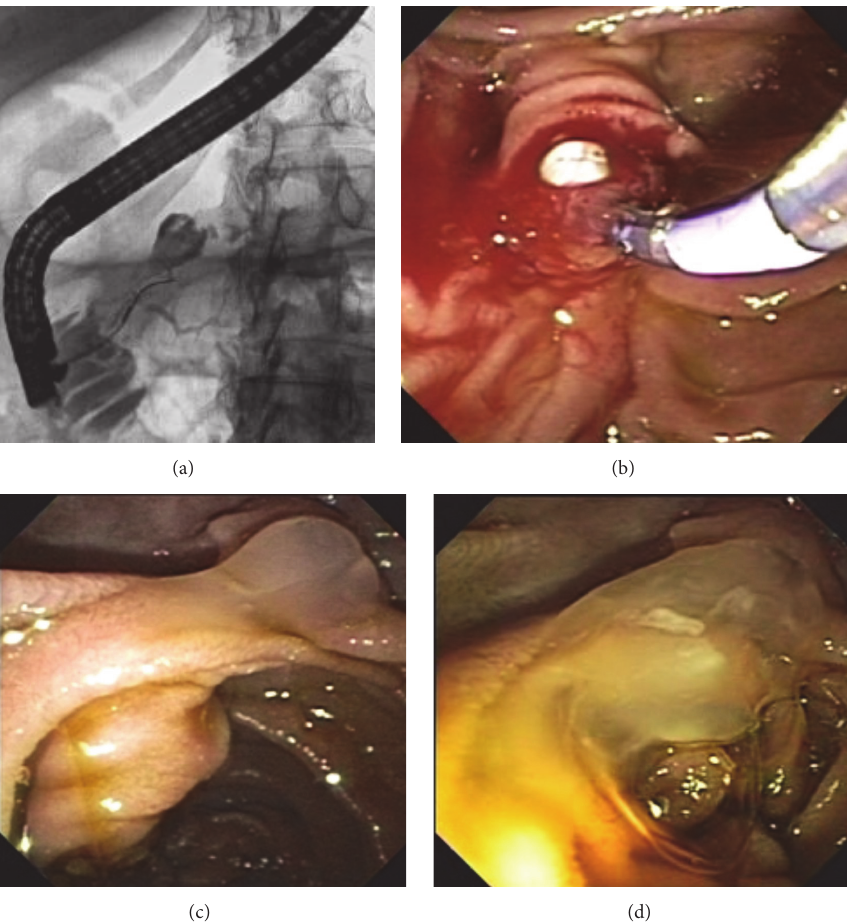
Figure 2: ERCP. (a) ERCP: incomplete contrast injection in the pancreatic duct. Cystic dilatation of the main pancreatic duct in the head of pancreas; initial opacification of less dilated duct in the body. Note normal caliber duct in uncinated process. (b) Pancreatic papillotomy, followed by passage of white pancreatic stone. No mucin was seen at this moment. (c) “Fish eye” sign; mucin spurring from the minor papilla. (d) Flow of mucin from the minor